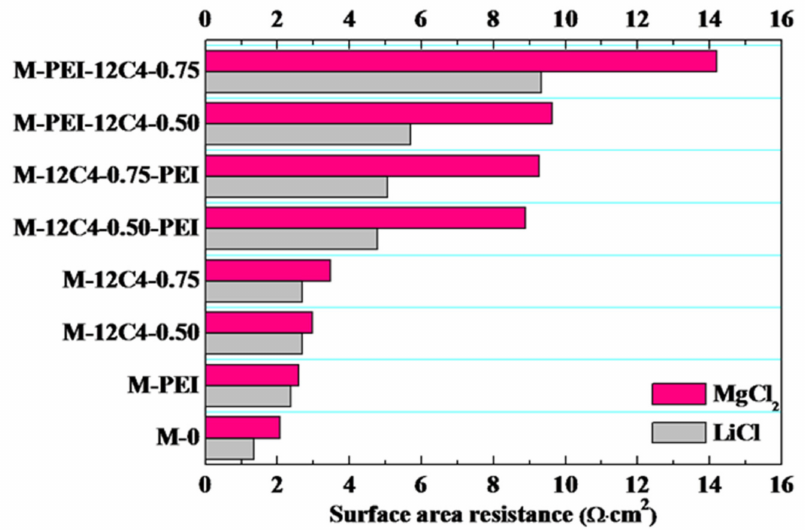
Figure 7. Surface area resistances for the pristine (M-0) and modified membranes (M-PEI, M-12C4-x, M-12C4-x-PEI, M-PEI-12C4-x, x = 0.50 and 0.75).